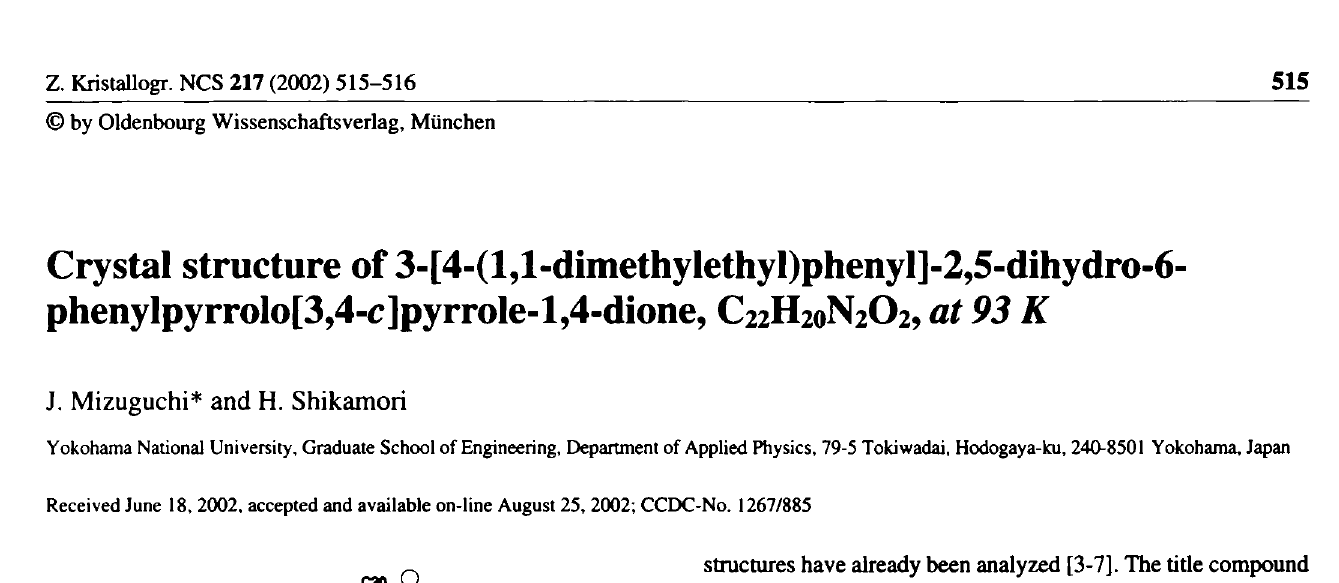
Table 1. Data collection and handling.